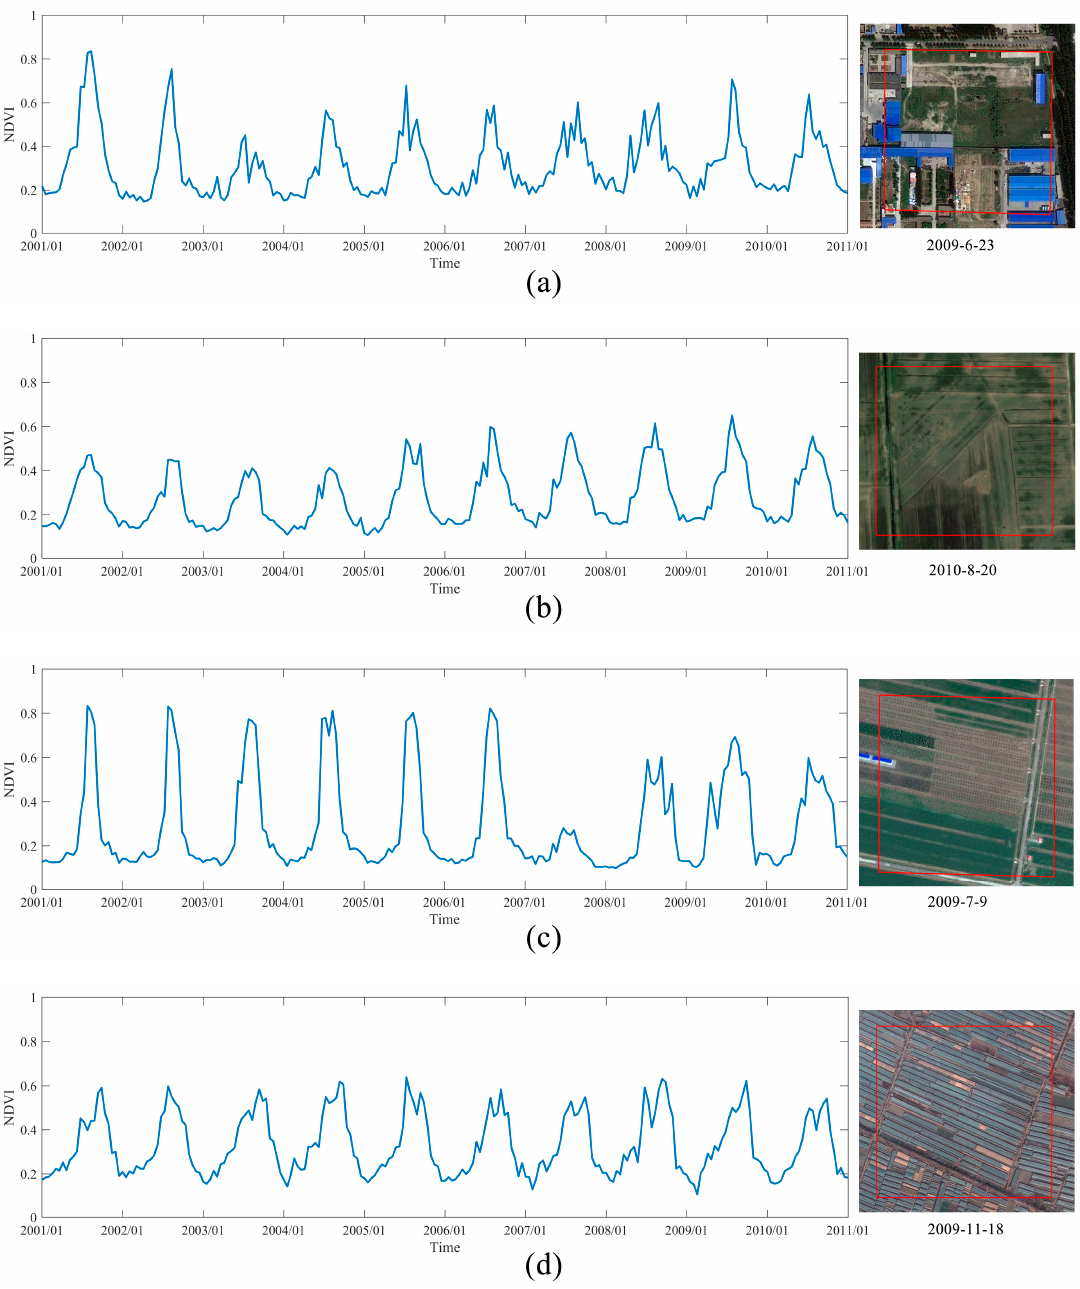
Figure 15. Four plots ( a – d ) of the misclassified pixels against the background of Google Earth high-resolution images, the NDVI time series of the corresponding MODIS pixel (on the left), and the pixel locations in the Google Earth images (red polygons in the right images). Example ( a ) shows omission errors due to mixture of different land covers within the same pixel. Examples ( b – d ) show commission errors resulting from abandoned farmland ( b ), abnormal decrease of the NDVI profile ( c ), and the coverage of greenhouse ( d ), respectively.